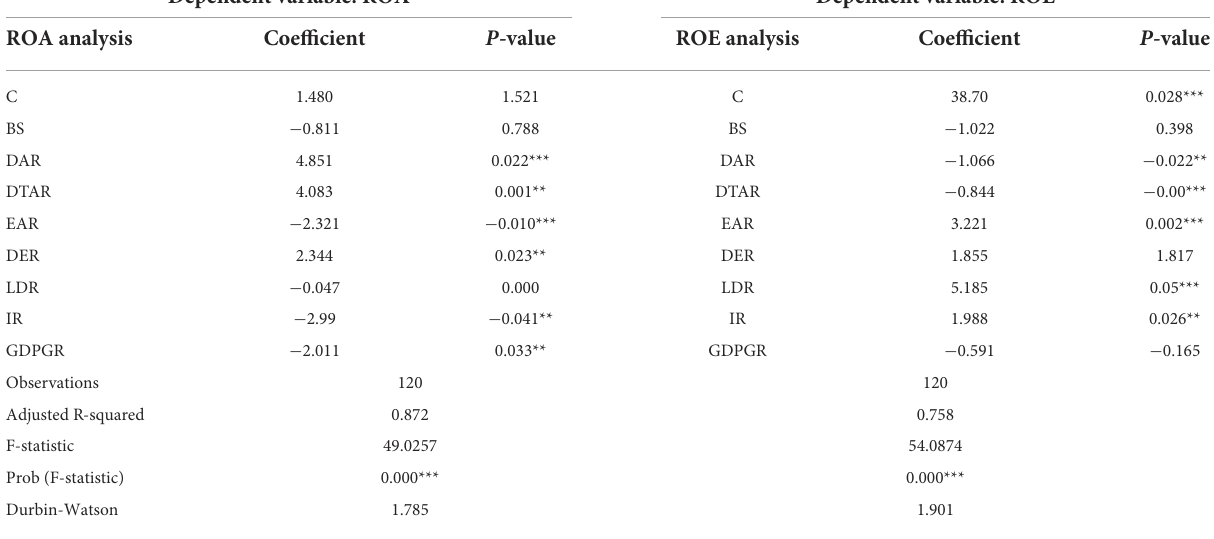
TABLE 11 Random effects estimation regression for banks’ profitability in India (measured by ROA and